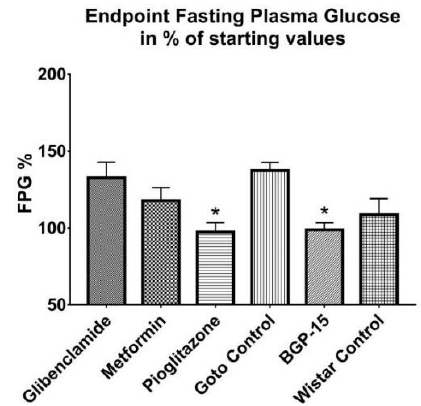
Figure 4. Endpoint fasting plasma glucose values expressed in percentages of starting fasting plasma glucose values. Data is presented as group mean ± standard error of the mean (SEM); n = 6 animals in each group. * p < 0.05 compared to Goto Control group; FPG = fasting plasma glucose. Statistical analysis was done using GraphPad Prism: after estimation of Gaussian distribution with Shapiro-Wilk normality test data was either analysed with one-way analysis of variance (ANOVA) or non-parametric Kruskal-Wallis test.